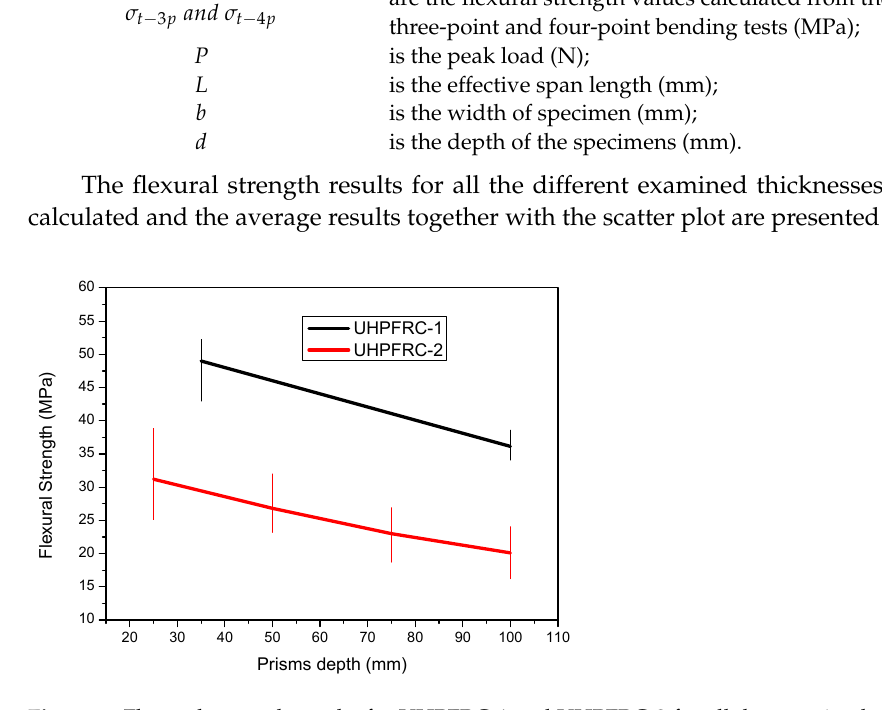
Figure 6. Flexural strength results for UHPFRC-1 and UHPFRC-2 for all the examined prism depths.